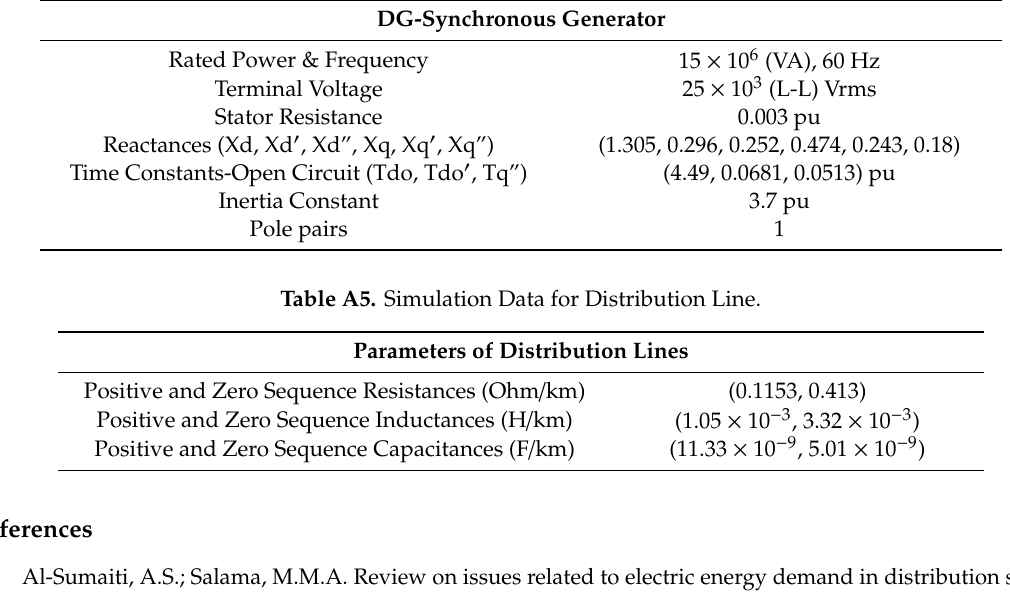
Table A4. Simulation Data for Synchronous Generator of the DG System.